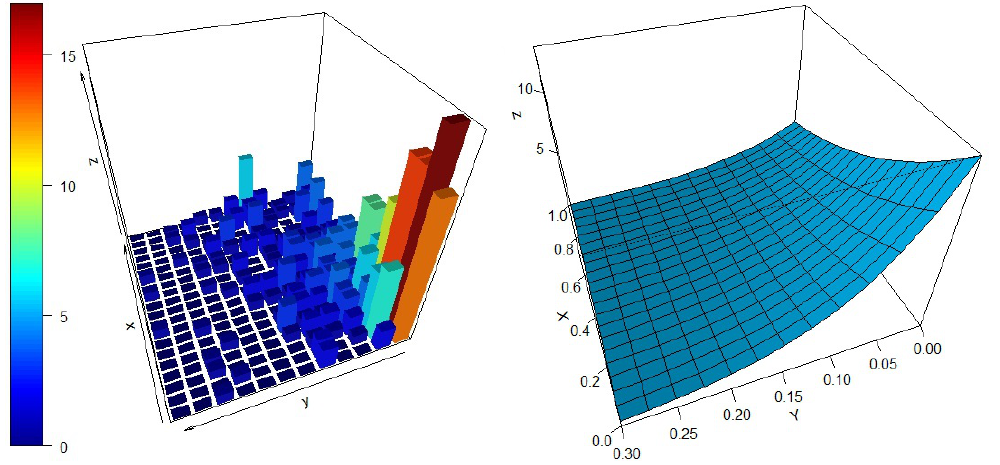
Figure 6. Histogram of real data ( left ) and Gumbel–Pareto pdf with the estimated parameters ( right ).